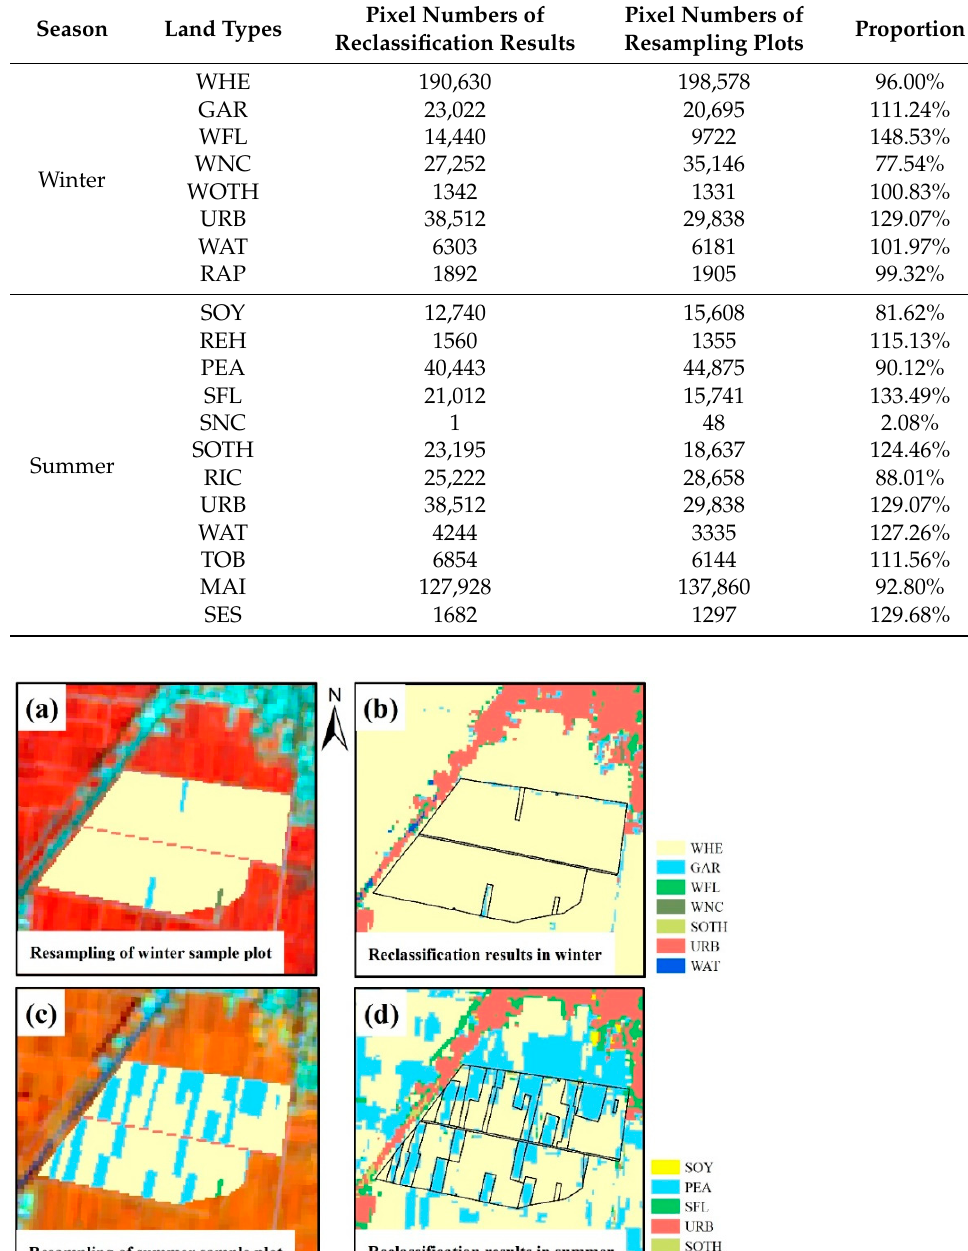
Table 4. Pixel numbers and proportion for both the reclassification results and resampling results in winter and summer.